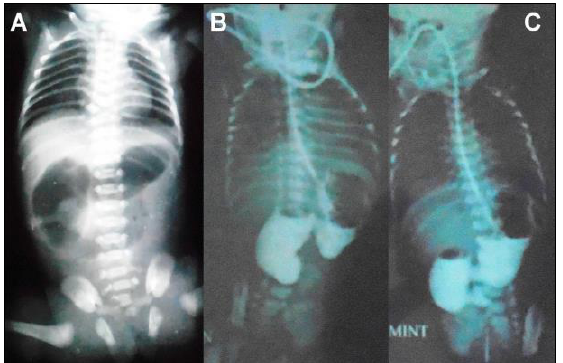
Figure 1: Abdominal X-ray showing gastric and duodenal gas (C- shape) shadow extending beyond the second part of duodenum along with absence of distal air (A); upper gastro-intestinal contrast study suggesting obstruction at the third part of the duodenum